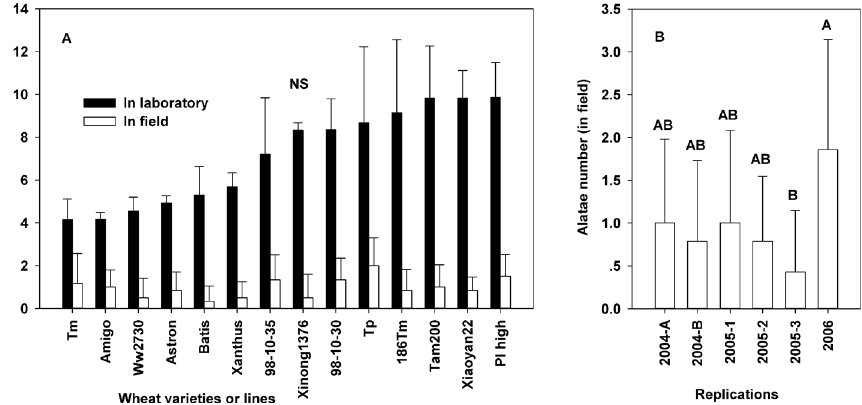
Fig 3. Average number of S . avenae alatae that chose each of the 14 wheat varieties/lines (mean ± SD). A: The alatae choose among 14 wheat varieties/lines in the laboratory after 24 h (black columns), and in the field during spring (white columns). B: Difference in the number of alatae among 6 fields/ sections in 3 years. ‘ NS ’ above the bar in part A was not significant at p < 0.5. Different capital letters above the bar in part B indicate the significance of differences according to